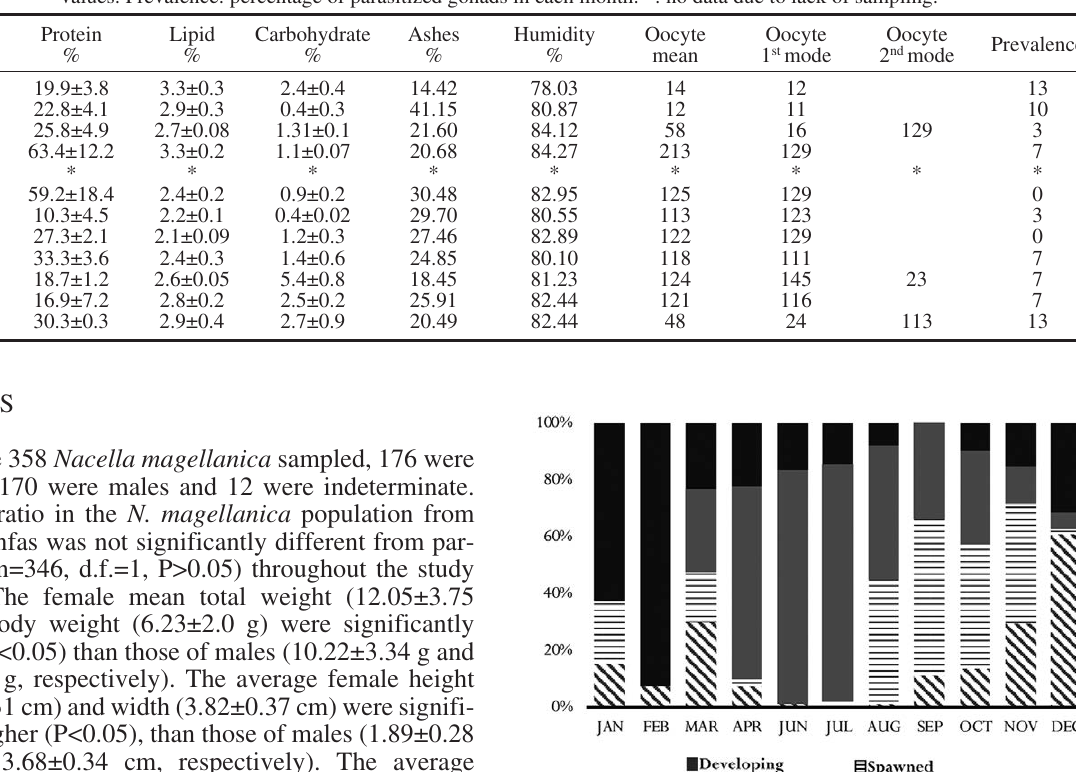
Table 3. – Monthly variation in the percentage values of proteins, lipids, carbohydrates, ashes (dry weight) and humidity. The ashes proportion includes the inorganic matter in the analysed individuals. Oocyte mean value in µm; oocyte modal diameters in µm, first and second modal